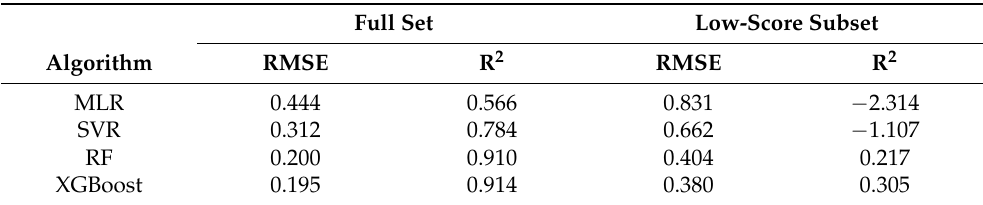
Table 3. RMSE and R 2 values for the MLR, SVR, RF and XGBoost regression models for the full data set and the low-score subset.